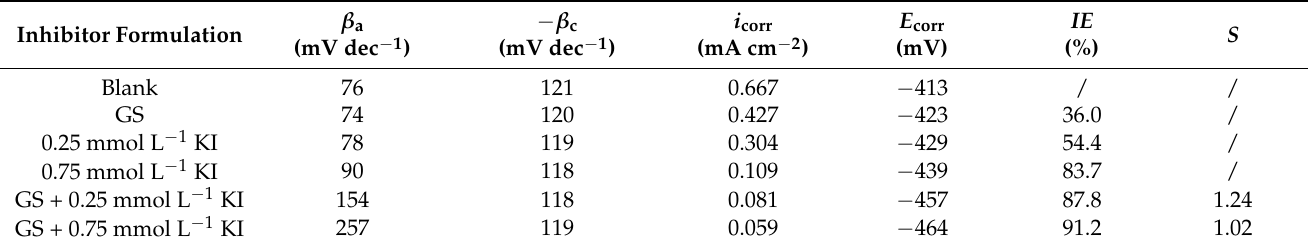
Table 4. Tafel fitting results of the electrodes in 0.5 mol L − 1 H 2 SO 4 solution without and with different corrosion inhibitor